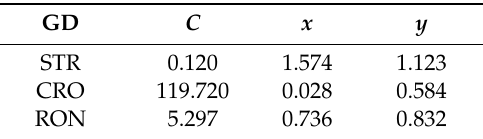
Table 4. Model coe ffi cients.